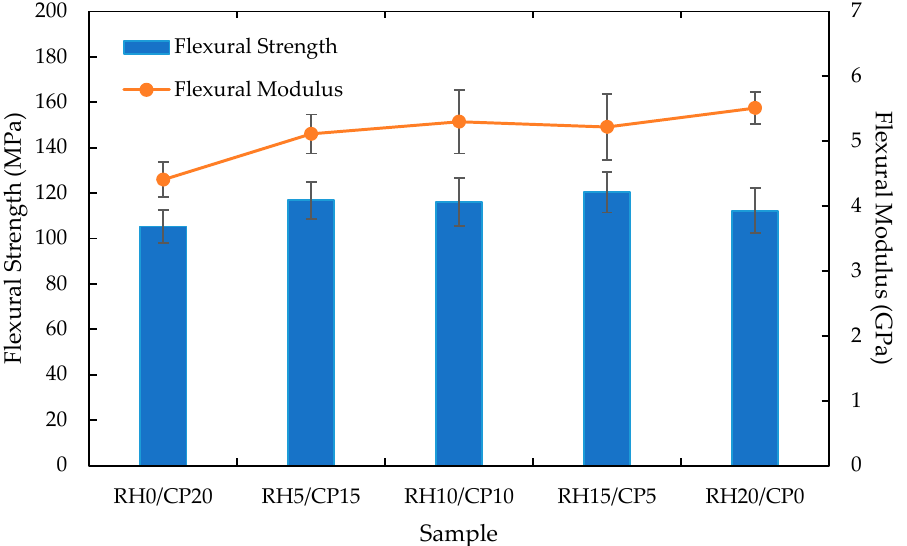
Figure 5. Flexural properties of RH/CP reinforced ABS blend composites.